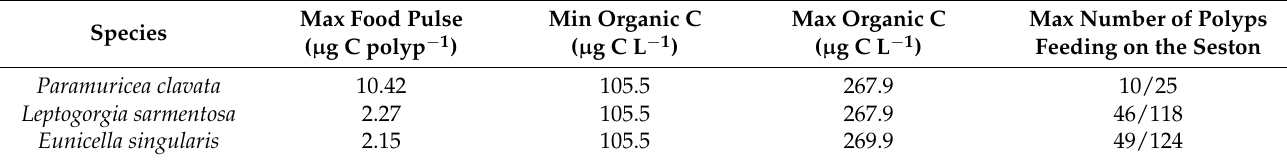
Table 7. Impact on the organic carbon (water near bottom seston) of the three studied species. The number of polyps feeding on seston is the ratio between the organic C (minimum and maximum) found in one liter (L − 1 ) of sea water and the maximum organic matter found in the polyps of each species (calculations made per day). Species